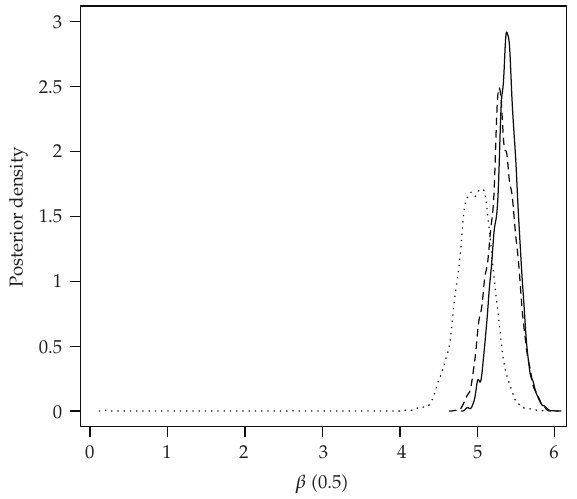
Figure 2: Plots of posterior densities for β 0 . 50 , where the dotted curve is for improper uniform prior, the dashed and solid curves are for power priors with parameters (cid:2) μ a (cid:2) 0 . 99 , 0 . 010 (cid:5) ,